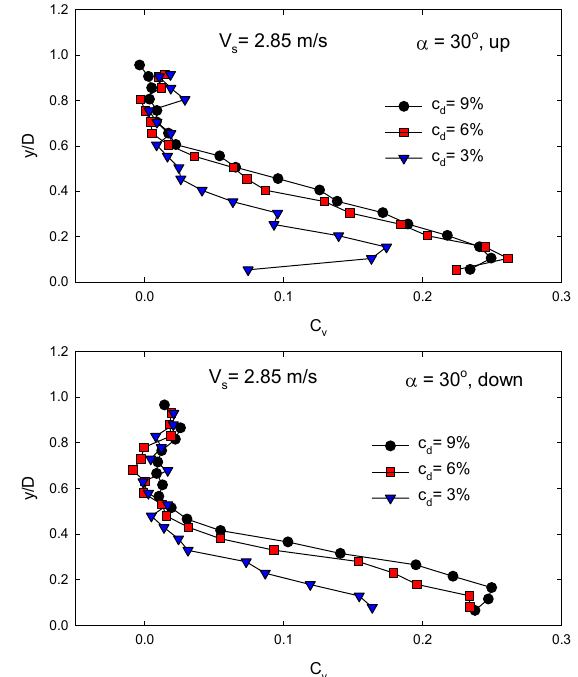
Fig. 6. Effect of the transport concentration c d on local concentration c v